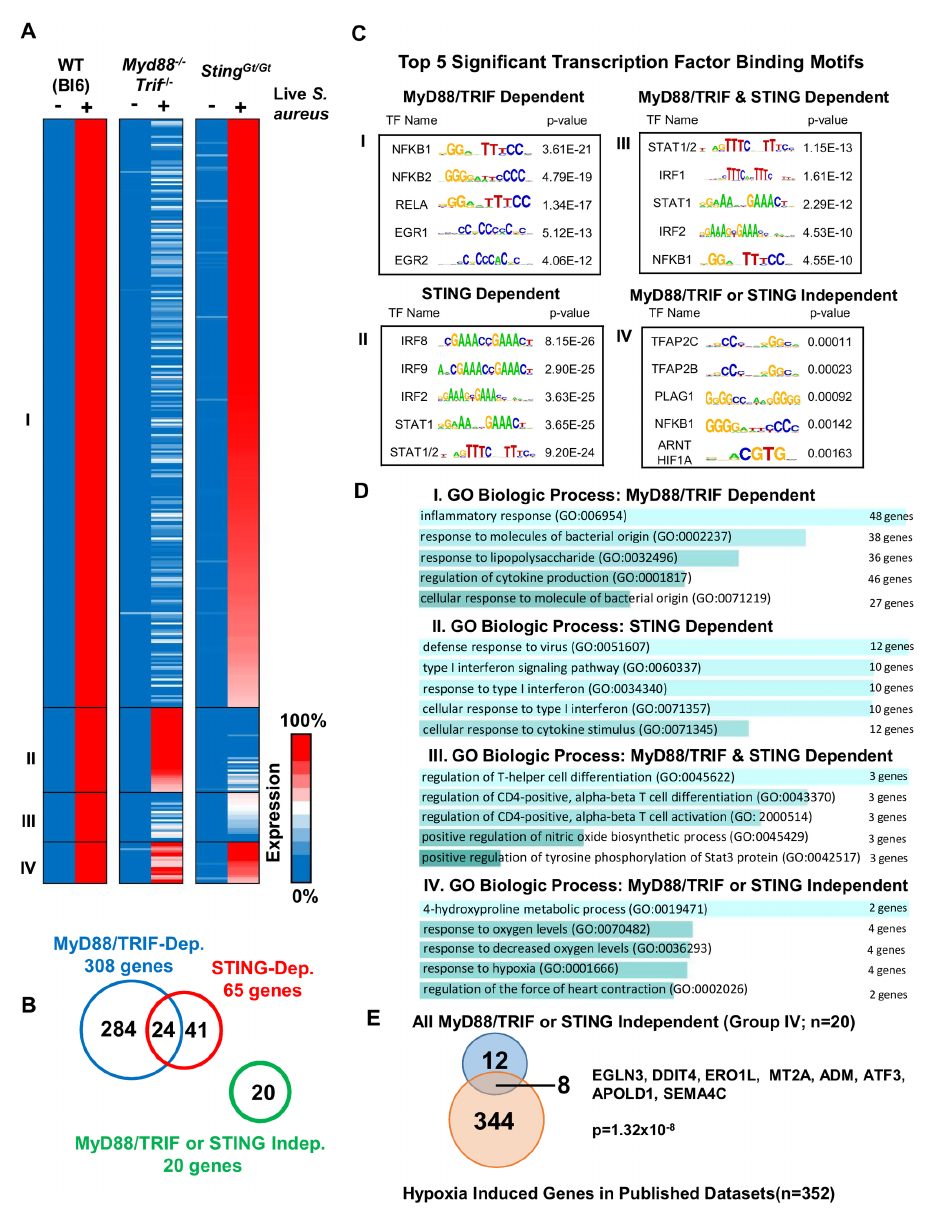
Fig 3. Integrated framework of transcriptional activation of genes induced in BMDMs by live S . aureus . (A) Heat map of percentile inductionof genes inducedby treatment of BMDMs with live S . aureus (MOI 10) in wild type (B6), Myd88 -/- Trif -/- , or Sting Gt/Gt mice reveals four distinct clusters of genes. Genes are separated into 4 clusters (I, II, III, and IV) based on mode of induction. (B) Venn diagramdemonstrating the breakdown of genesin the four clusters of genesbased on > 50% dependence on the two main pathways induced. (C) EnrichedJaspar 2016 motifs within promoters of genes within the 4 clusters of genesdefinedby dependence on TLR and/or STING pathways. (D) GO BiologicProcess revealsfunctions of geneswithin each cluster. The number of geneslisted next to the GO BiologicProcess number refers to the number of S . aureus -induced genes in our dataset that contribute to the significantenrichment of the GO term dataset. (E) Comparison of “MyD88/TRIF or STING Independent” cluster of 20 geneswith known monocyte/macrophage datasets stimulated with hypoxiarevealssignificantoverlap of signatures (p-valueby Fisher’s Exact Test).